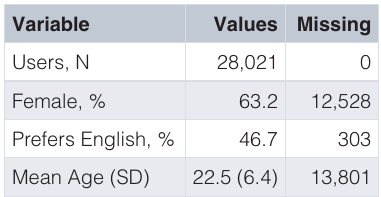
Table 1. Characteristics of